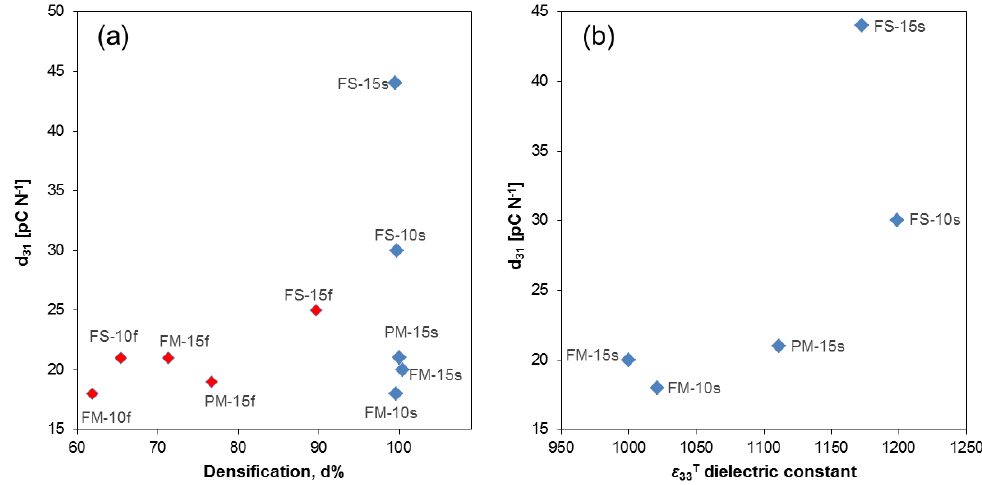
Figure 6. ( a ) Value of the d 31 piezoelectric coefficient vs. densification (all samples). ( b ) Value of the d 31 piezoelectric coefficient vs. 𝜀 33𝑇 dielectric constant (fully densified materials only). Color coding as follows to aid the reader to evaluate correlations: red diamonds: fast sintered samples (s); blue diamonds: slow sintered samples (f).